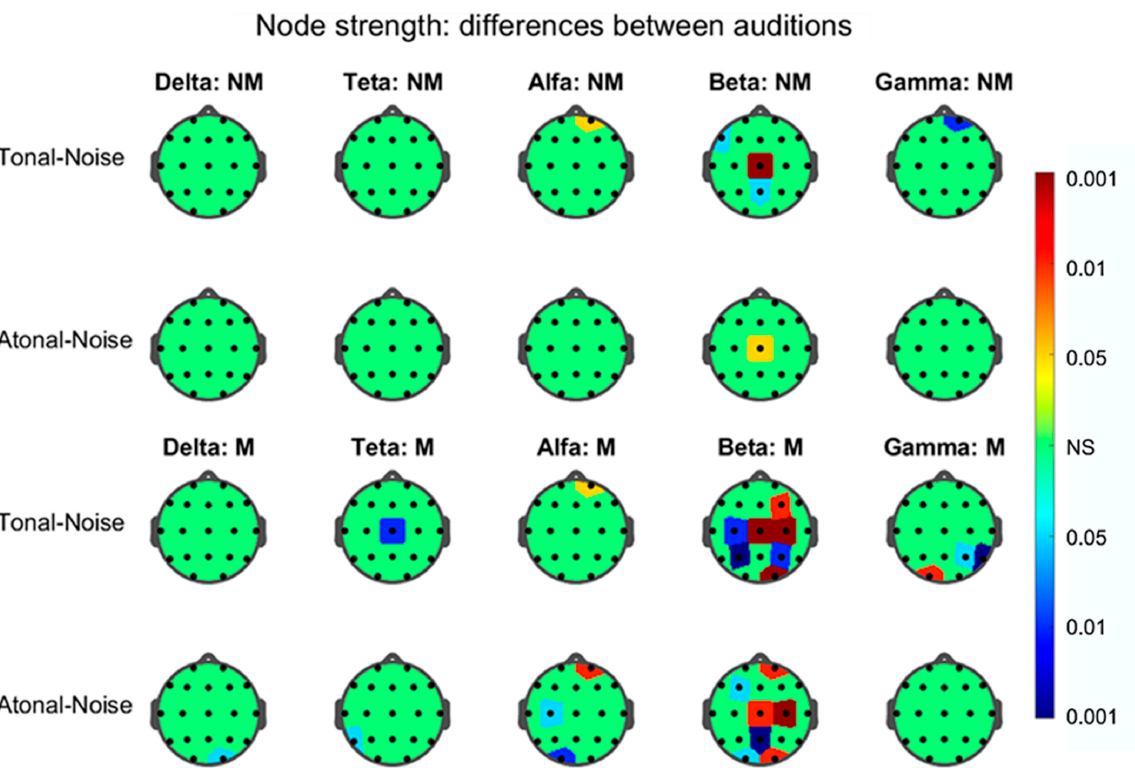
Figure 9. Statistical significance values ( p ) of the difference of the node degree between tonal-noise and atonal-noise auditions (left column) for the different nodes of the five graphs of each EEG frequency band pointed out. The color of the area around each node corresponds to the significance level P indicated in the color-bar on the right (valid to all heads); the colors were associated with the three levels of significance ( p < 0.001, p < 0.01, and p < 0.05) by using three range of reds when the difference was positive and three range of blues when it was negative. Nodes without statistical significance (NS) appear in green. In the upper two rows the values for non-musicians (NM) appear in the indicated frequency bands and in the lower two those corresponding for musicians (M) group.